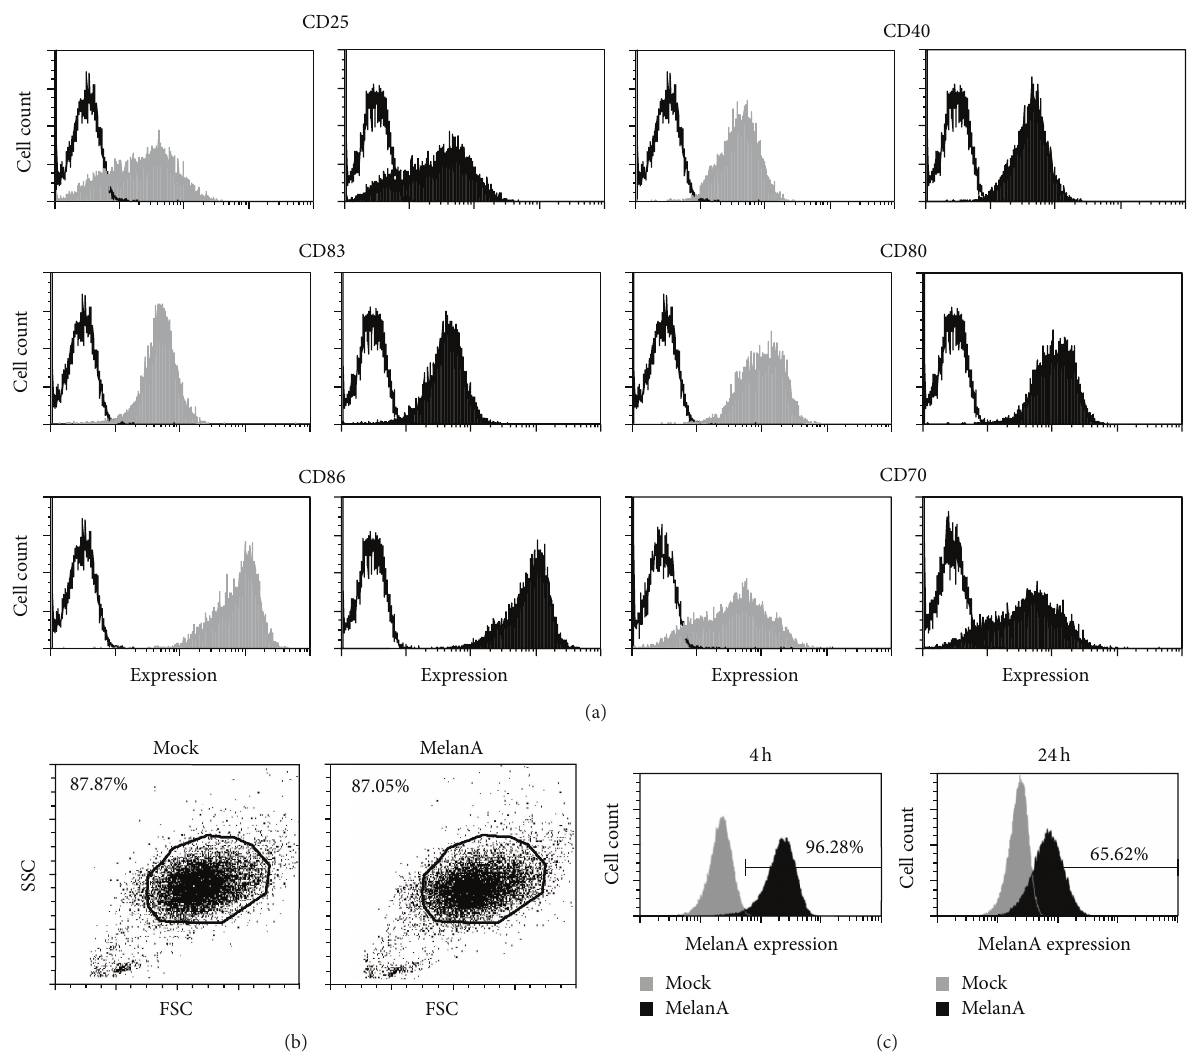
Figure 1: MelanA is expressed in cocktail-matured, monocyte-derived DCs after mRNA electroporation. DCs were either electroporated without mRNA (mock; gray histogram) or with mRNA encoding the tumor antigen MelanA (MelanA; black histogram). (a) Surface marker expression of CD25, CD40, CD83, CD86, CD70, and CD80 on mock-electroporated and MelanA-RNA-electroporated DCs 24 h after electroporation is shown (black lines; respective isotype controls). One representative of ≥ 4 experiments is shown. (b) Gating of mock- electroporated (Mock) or MelanA-RNA-electroporated (MelanA) DCs was performed according to forward and side scatter. (c) Four and twenty-four hours after electroporation, the intracellular MelanA expression was determined by flow cytometry. The percentage of positive cells is indicated. One representative of > 10 experiments is